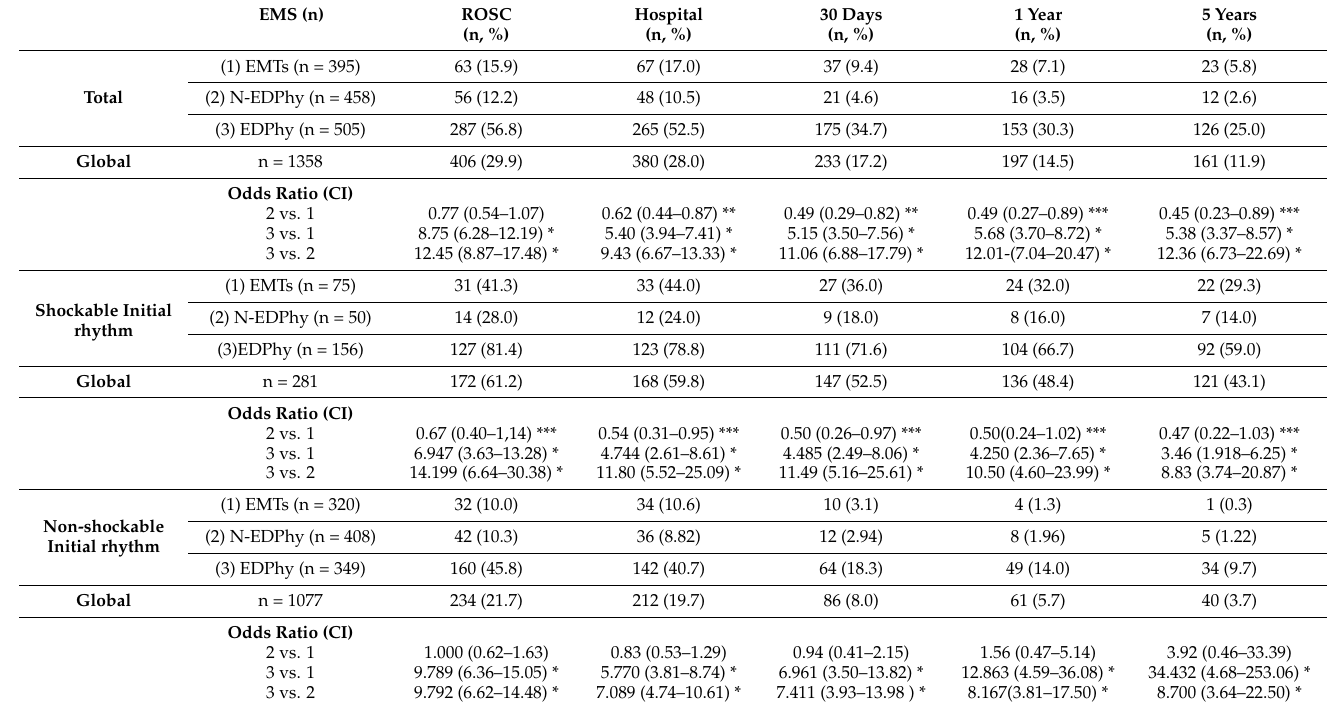
Table 2. Survival of the sample (any ROSC, upon arrival at the hospital, one month, one year, and five years after the event based on the EMS that attends it and the initial rhythm).